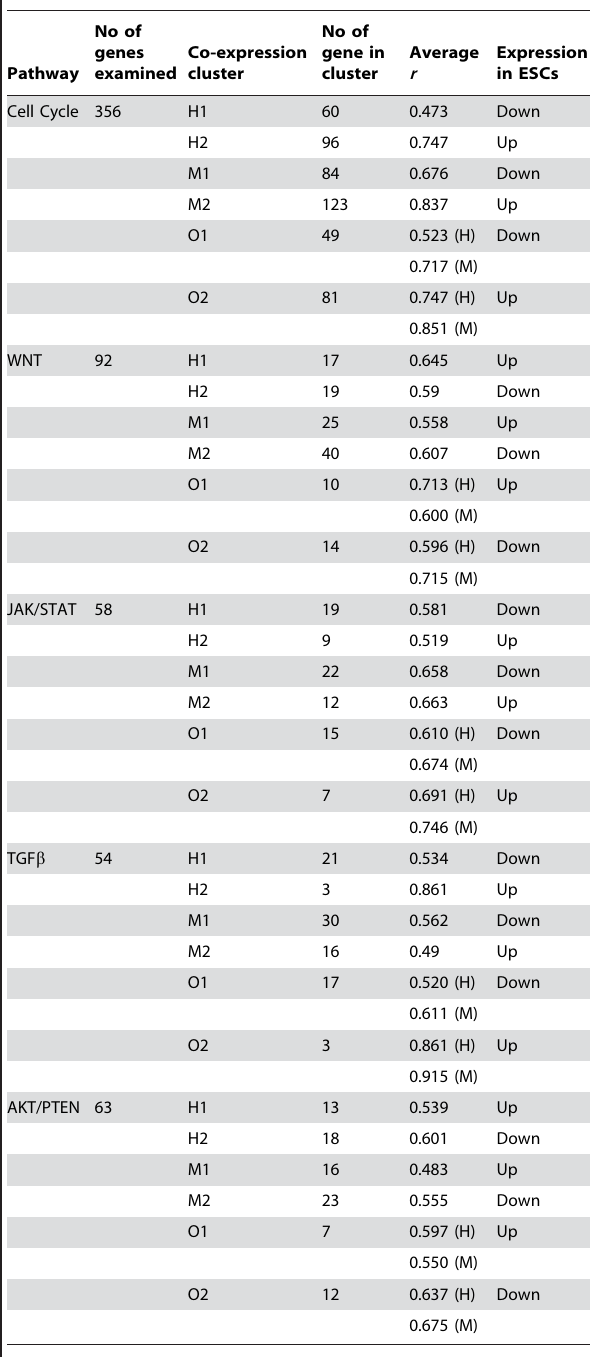
Table 1. Summary of the identification of co-expression gene clusters in ESC-critical pathways by GSVD and cPAM. O1 and O2 are conserved clusters jointly identified by both